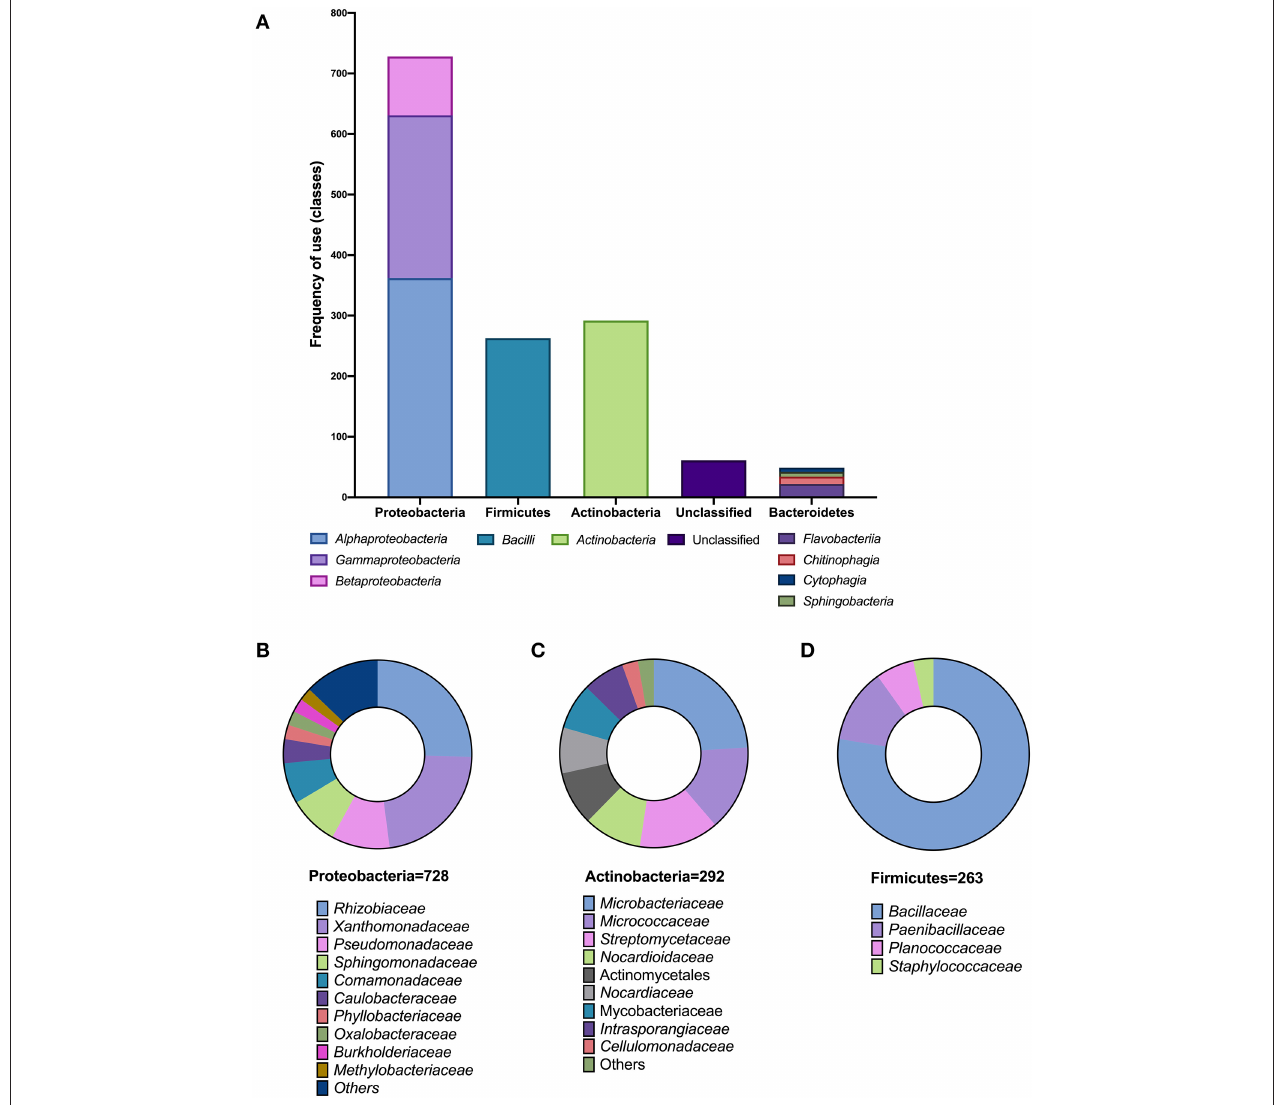
FIGURE 2 | Taxonomic analysis of SynCom compositions. (A) Frequency of use (number of members) in different classes within each phylum in the reported SynComs. Families of the members of SynCom of the phyla Proteobacteria (B) , Actinobacteria (C) , and Firmicutes (D)